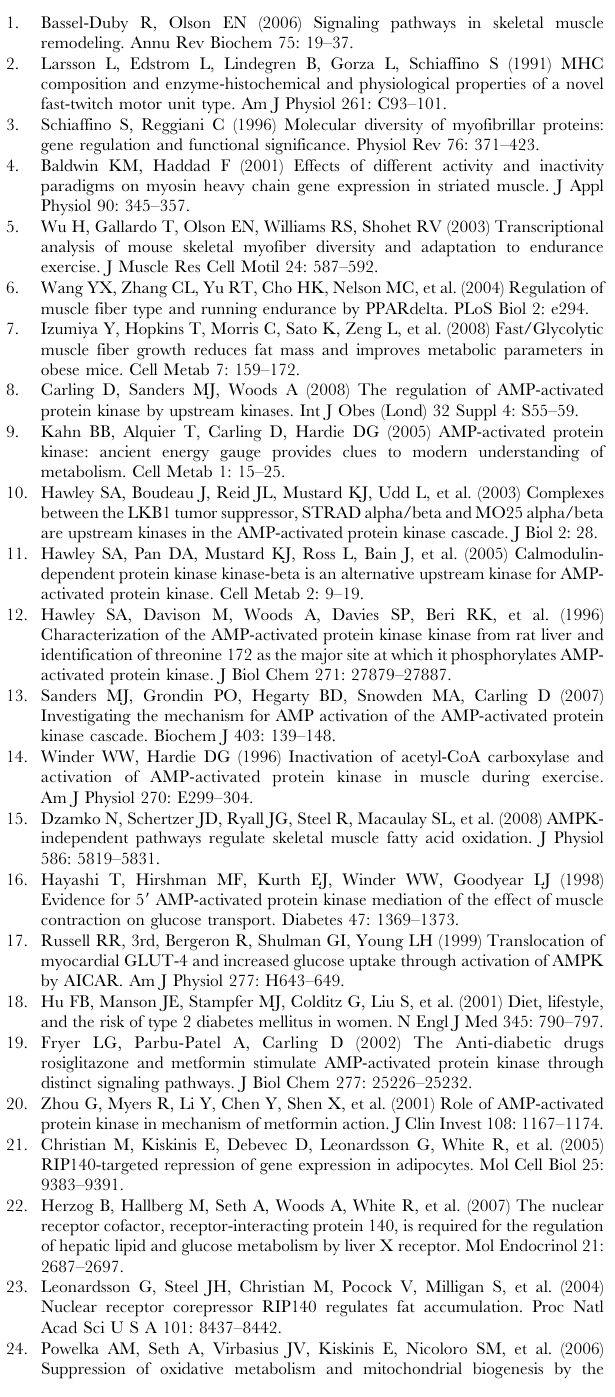
Figure S7 UCP1 promoter activity is inducible in C2C12. Cells were transfected with UCP1(4 kb)-luciferase reporter and vectors expressing (A) PPAR a , (B) PPAR b / d , (C) ERR a , (D) CREB or ATF2, and treated with (A) 100 m M WY14643 (WY), (B) 10 m M GW501516 (GW), (C) 10 m M XCT790 (XC), (D) 10 m M Forskolin (Fo) or vehicle (-) as indicated. Data are expressed as mean 6 SEM, *p , 0.05 vs